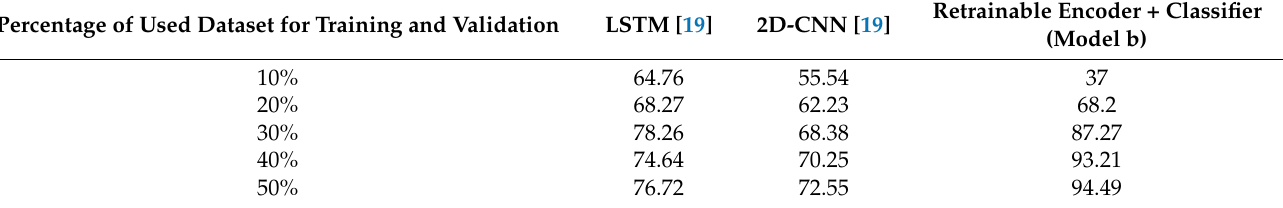
Table 6. Comparing average accuracy of classifier included by the retrainable encoder with LSTM and 2D-CNN-based classifiers from [19] using different percentages of data. Percentage of Used Dataset for Training and